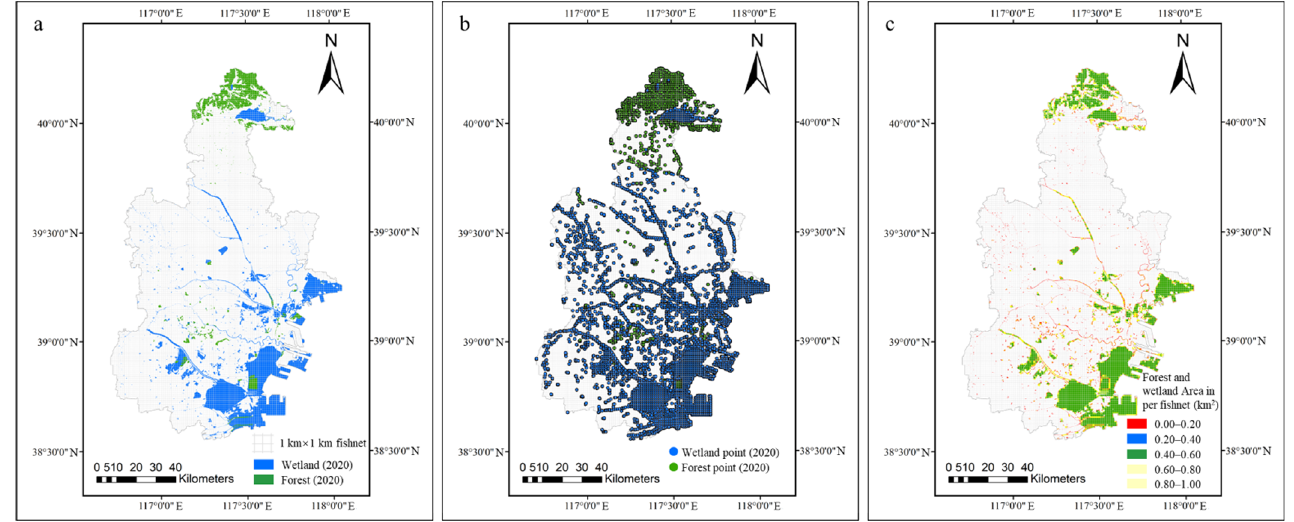
Figure 4. The forest/wetland spatial data in Tianjin (2020) ( a ), point features of forest/wetland in Tianjin (2020) ( b ), forest and wetland area in per fishnet ( c ).